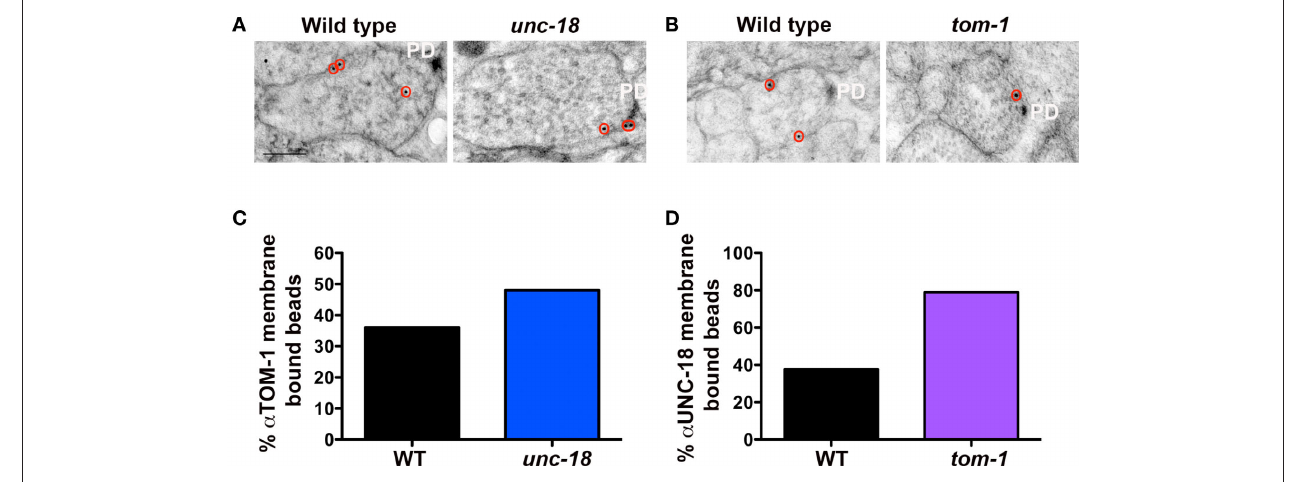
FigUre 5 | UNC-18 and TOM-1 compete for plasma membrane-association. Representative micrographs showing immunogold labeling of TOM-1 in wild-type and unc-18(md299) mutant synapses (A) and UNC-18 labeling in NMJs of wild-type and tom-1(ok285) mutants (B) . Immunogold particles are circled. PD indicates the presynaptic density. Scale bar 200 nm. (C, D) The percentage of total synaptic beads that are associated with the plasma